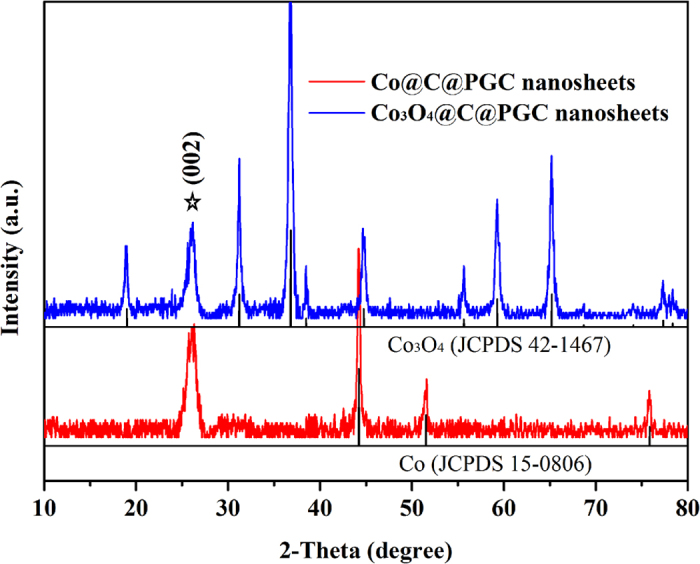
The typical XRD patterns of the Co@C@PGC nanosheets and Co3O4@C@PGC nanosheets.